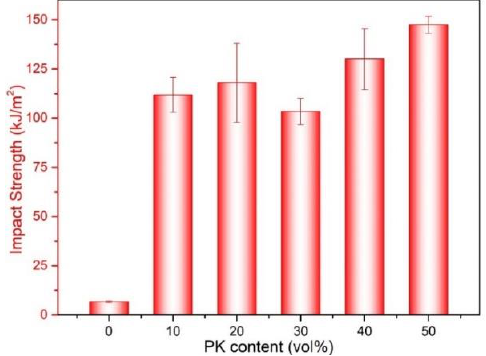
Figure 9. The impact strength of PA12 and PA12/PK blends.